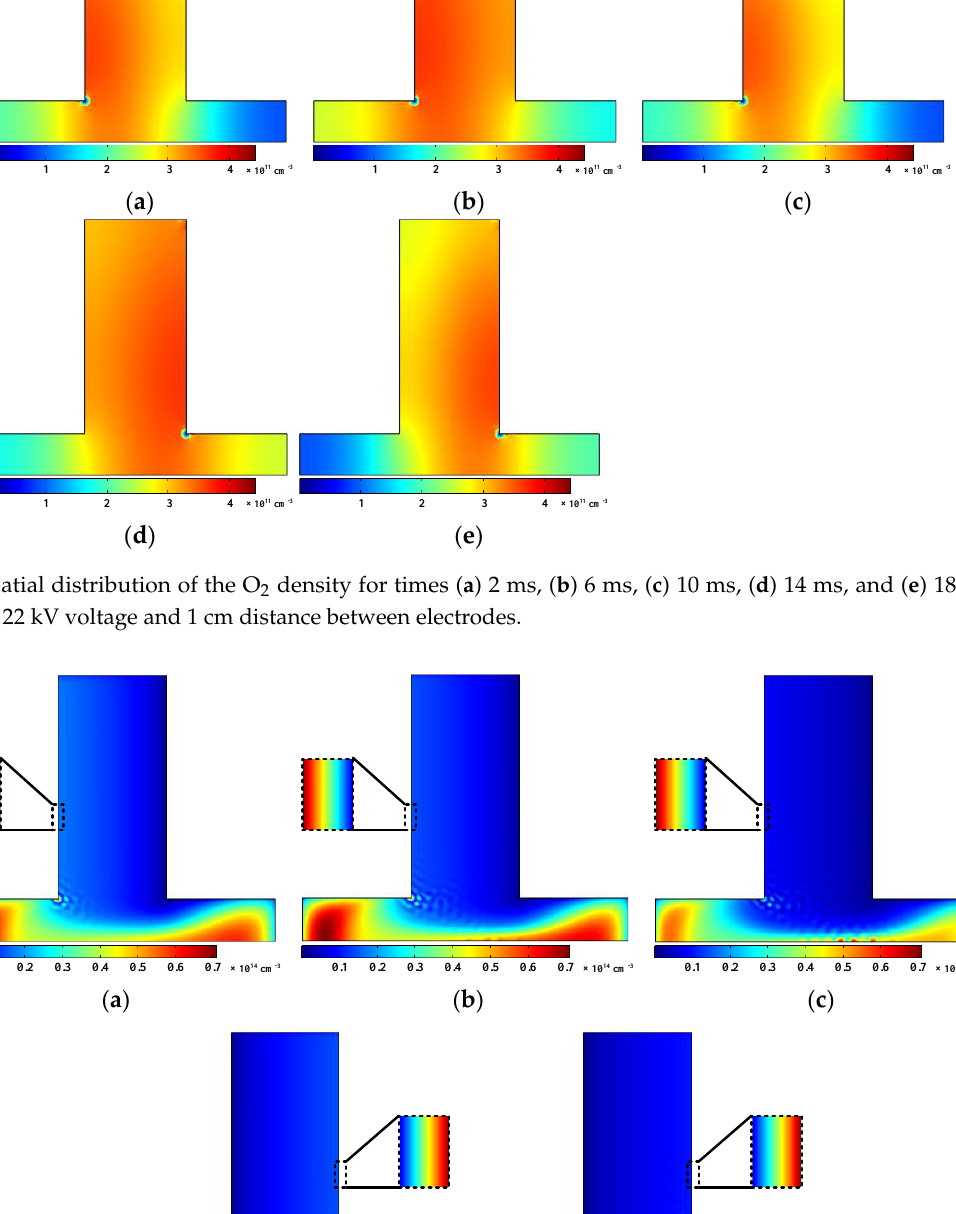
Figure 17. Spatial distribution of the O- ion density for times ( a ) 2 ms, ( b ) 6 ms, ( c ) 10 ms, ( d ) 14 ms, and ( e ) 18 ms for the reactor at 22 kV AC voltage and 1 cm distance between electrodes.